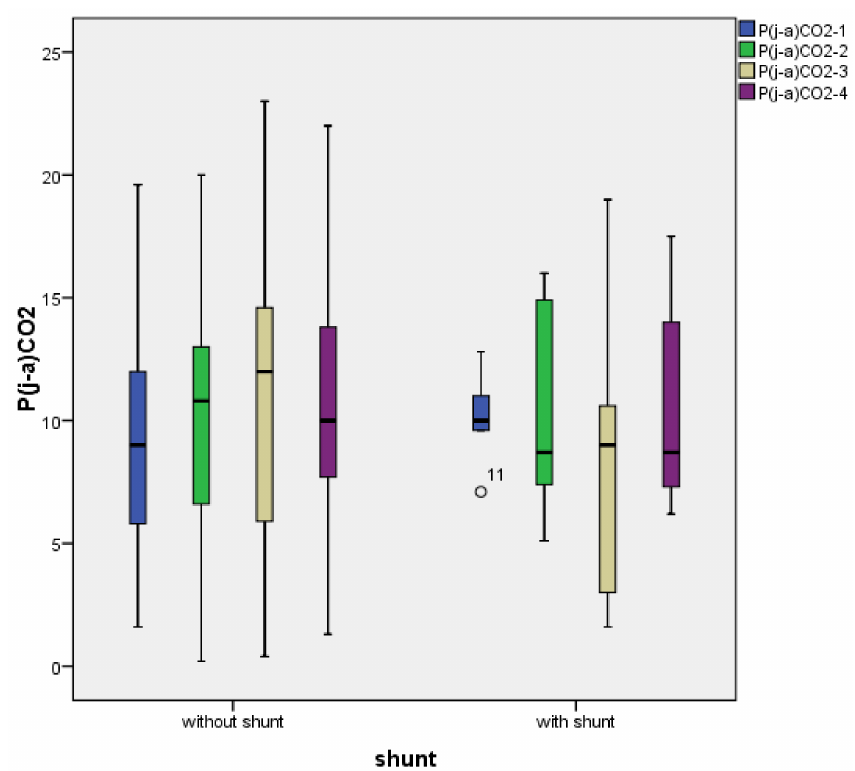
Figure 1. Jugulo-arterial carbon dioxide gap (P(j-a)CO 2 ) dynamics through the operation, in four different time points: T1 (blue), T2 (green), T3 (yellow), and T4 (purple). P(j-a)CO 2 (mmHg) is expressed as a box-plot